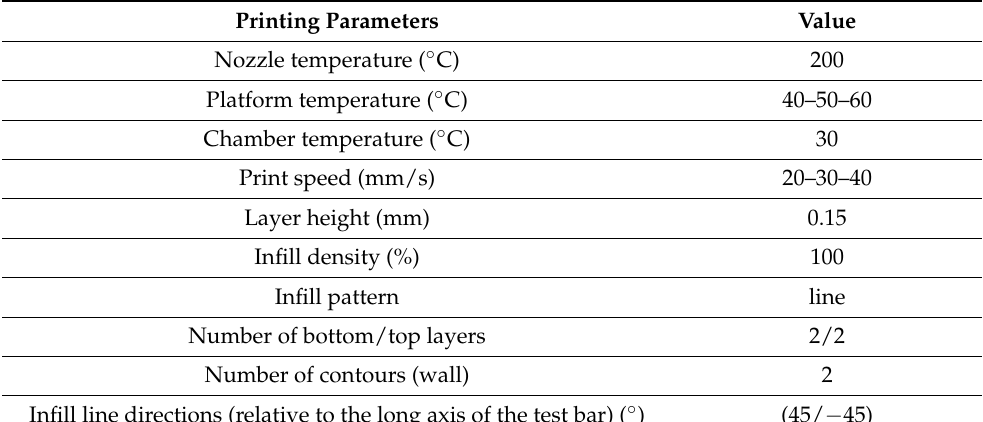
Table 2. Representation of chosen parameters for 3D printing of PLA-Graphene